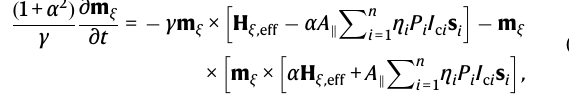
H x of +600Oe and − 600 Oe, respectively. d , e Extracted critical current density J andswitchingratioasafunctionof t MgO .Thesolid-linein e isanexponential fi tting. f Anomalous Hallresistivity ρ H and switching ratioof Ta(2)/MgO(2)/Mn 3 Sn(12)asa function of